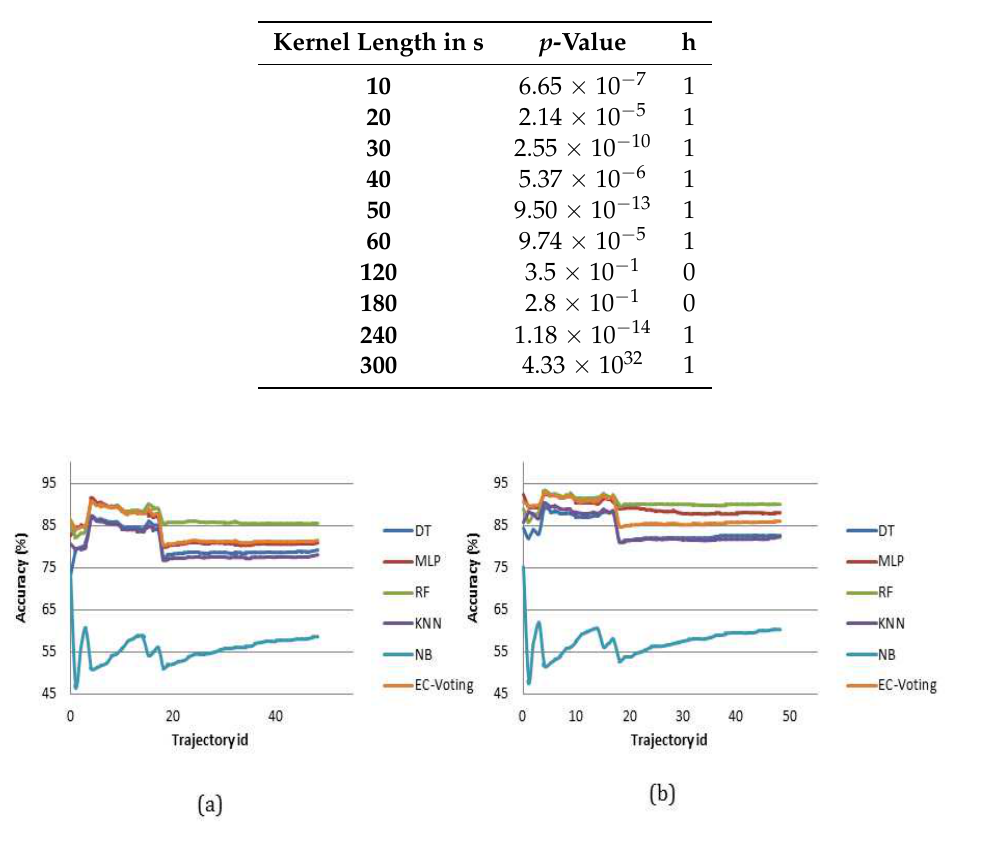
Table 4. Context 1, Scenario 1: Measuring statistical significance of prediction accuracy between MLP and RF based classifiers at 5% significance level. A p -value ≤ 0.05 and h -value = 1 signifies the result is statistically significant.